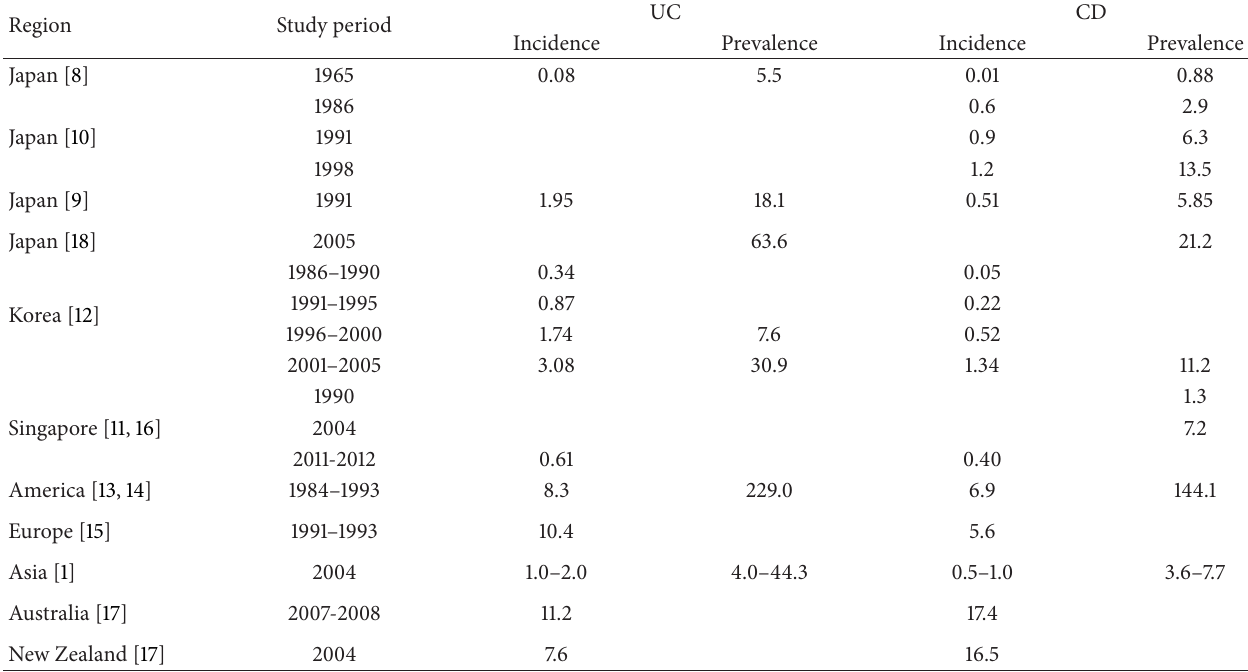
Table 2: Incidence and prevalence (per 100,000) of IBD from Europe, America, and other Asian Pacific countries.